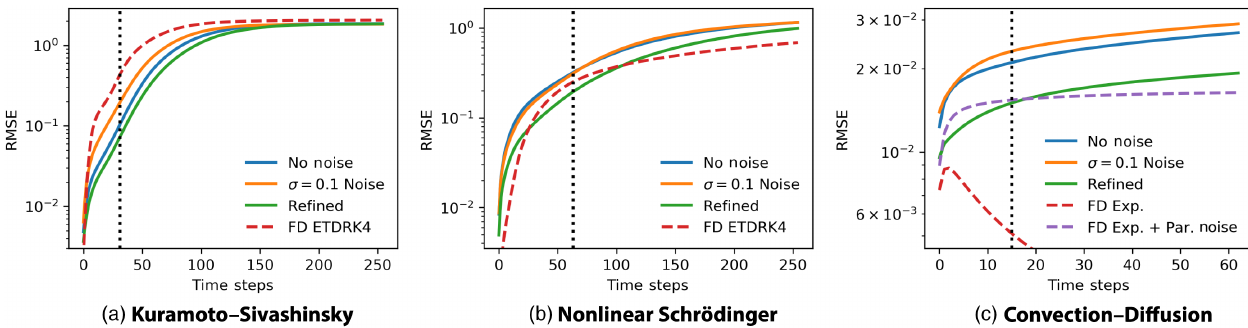
FIG. 4. The root mean square prediction error (RMSE) during evaluation at each propagation time step, averaged over the corresponding test set, for models trained without noise (blue line), trained with σ ¼ 0 . 1 Gaussian noise (orange line), and refined by fixing the DE and training with 64 hidden channels in the PD network on the noiseless datasets (green line). Shown for comparison is an evaluation by a second-order finite difference (FD) discretization integrated with the ETDRK4 method [35] (dashed red line), which reduces to an exact exponential integrator for the 2D convection-diffusion system. Also, since the prediction accuracy on 2D convection- diffusion is dominated by parameter extraction uncertainty, we include for comparison the solver with additional parameter noise: σ ¼ 0 . 005 for D , σ ¼ 0 . 01 for v , v (dashed purple line). The black vertical dotted line denotes the length of the target series T x y training each set of models, i.e., the maximum number of time steps propagated by the model during